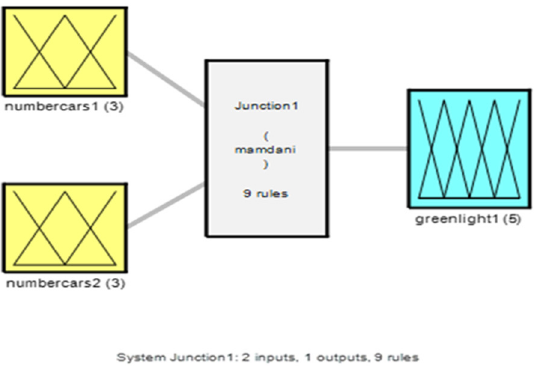
Figure 1. Fuzzy controller for junction 1 with two inputs, one output and nine rules.